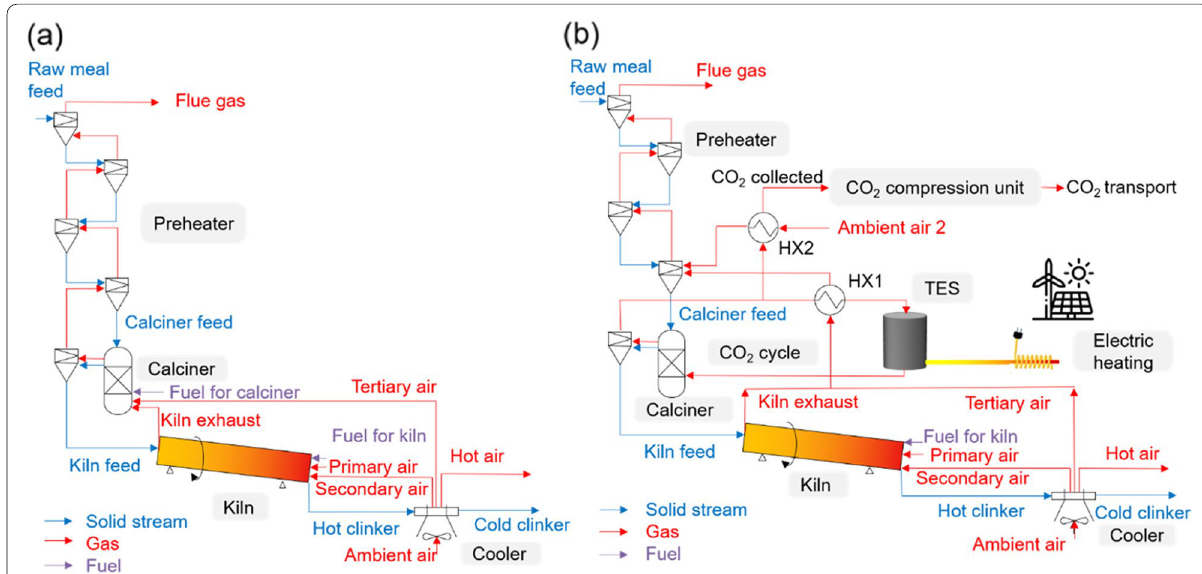
Fig. 1 a The reference cement manufacturing process. b The cement manufacturing process with calciner powered by the TES